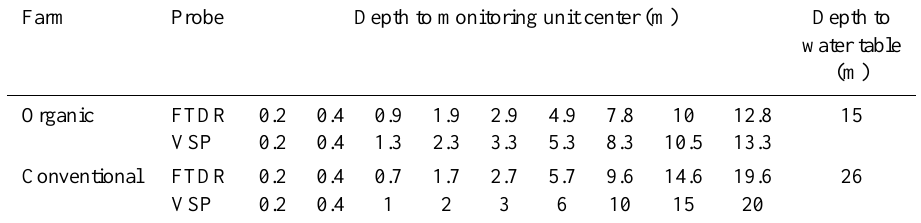
Table 1. Vertical distribution of monitoring units across the vadose zone of the organic and conventional farms. Farm Probe Depth to monitoring unit center (m) Depth to Organic